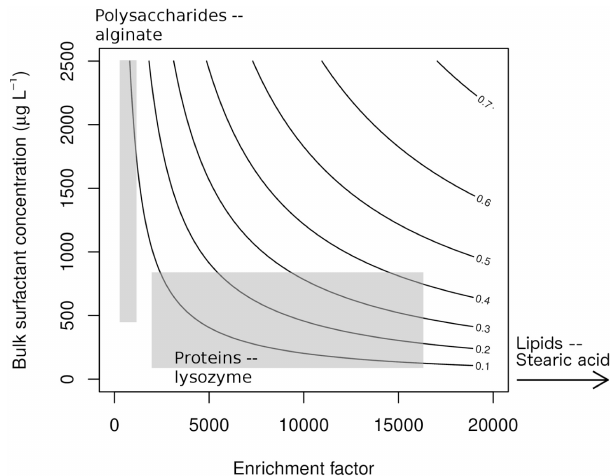
Figure 3. Organic mass fraction in dry aerosol (OM:(NaCl+OM) mass ratio), as a function of enrichment factor and ocean organic mass. Approximate ranges of mass and enrichment factors for polysaccharides and proteins, as defined in Sect. 3.2 and Sect. 5.2, are indicated as gray shaded regions. Lipids would appear far to the right of the figure, near the